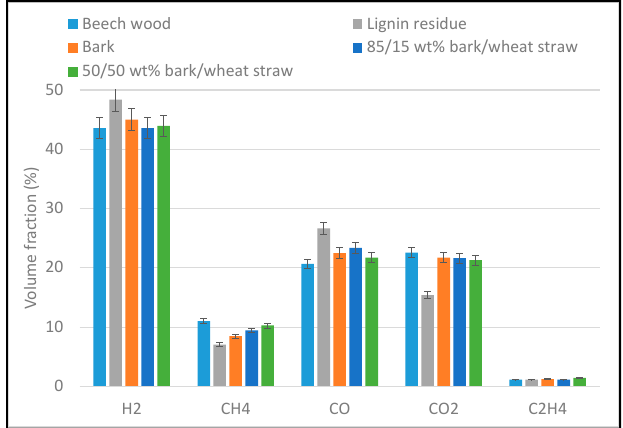
Figure 4. Mean dry gas composition for the gasification tests (main gas species).